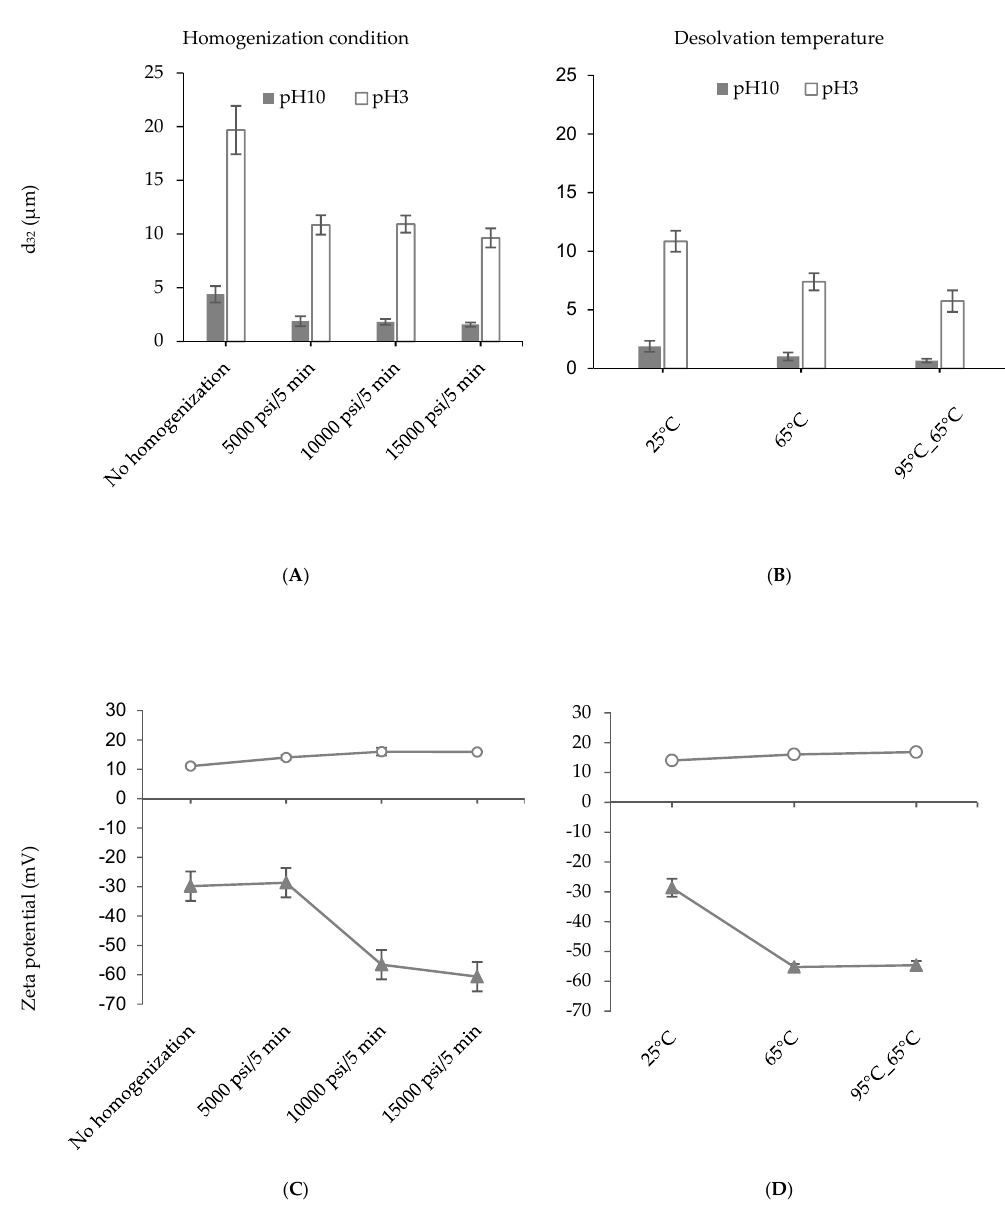
Figure 2. Influence of homogenization pressure ( A , C ) and heating ( B , D ) on average particle size ( A , B ), and surface charge ( C , D ) of pea protein particles at pH 10 (close triangles) and pH 3 (open circles). Pea protein particles were prepared with 5 × desolvation ratio of alcohol to protein solution.